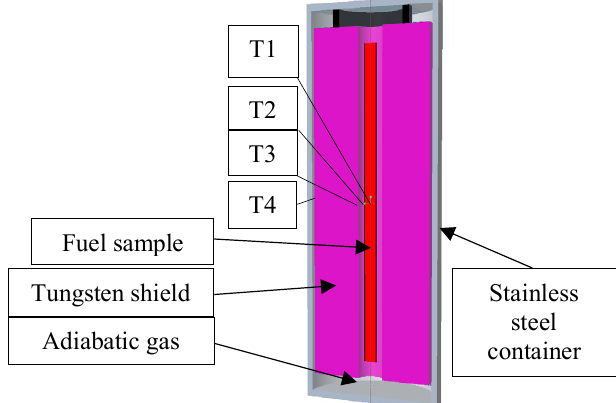
Fig. 2. The experimental device. In red: the fuel sample. In violet: the tungsten shield. In grey: the stainless steel container. T1, T2, T3, T4 are thermocouples placed in the fuel sample and the tungsten